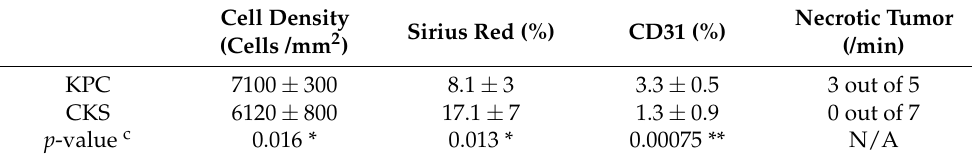
Sirius Red (%) CD31 (%)